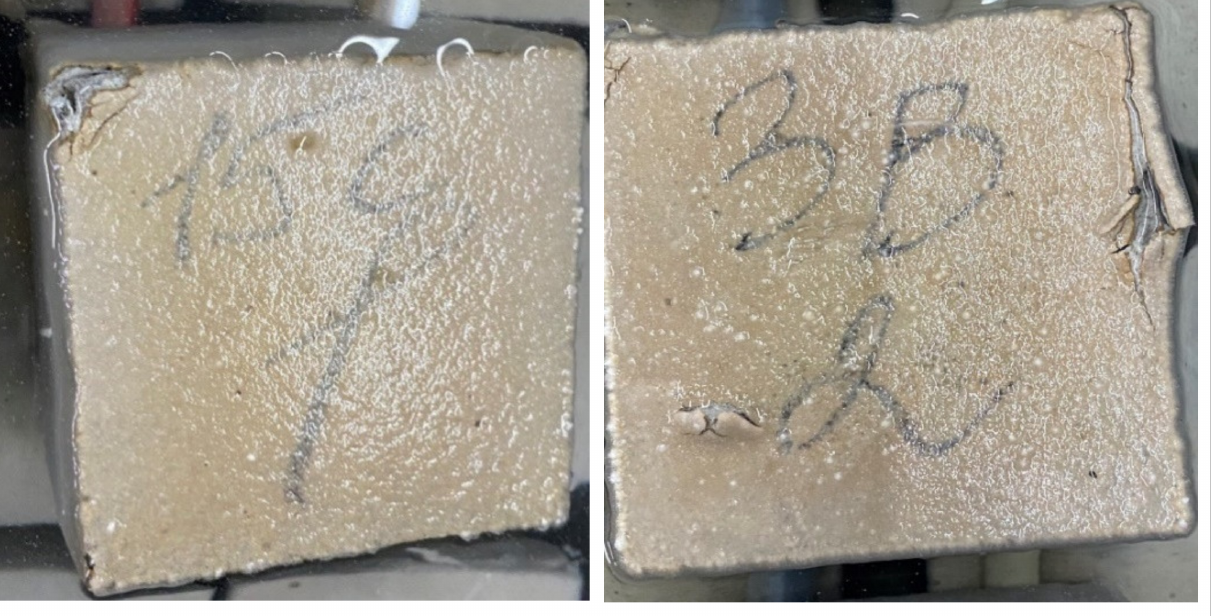
Figure 11. Specimens after 6 months exposure in an acidic environment, pH = 3. Total amount of specimens 84 cubes (12 cubes for each